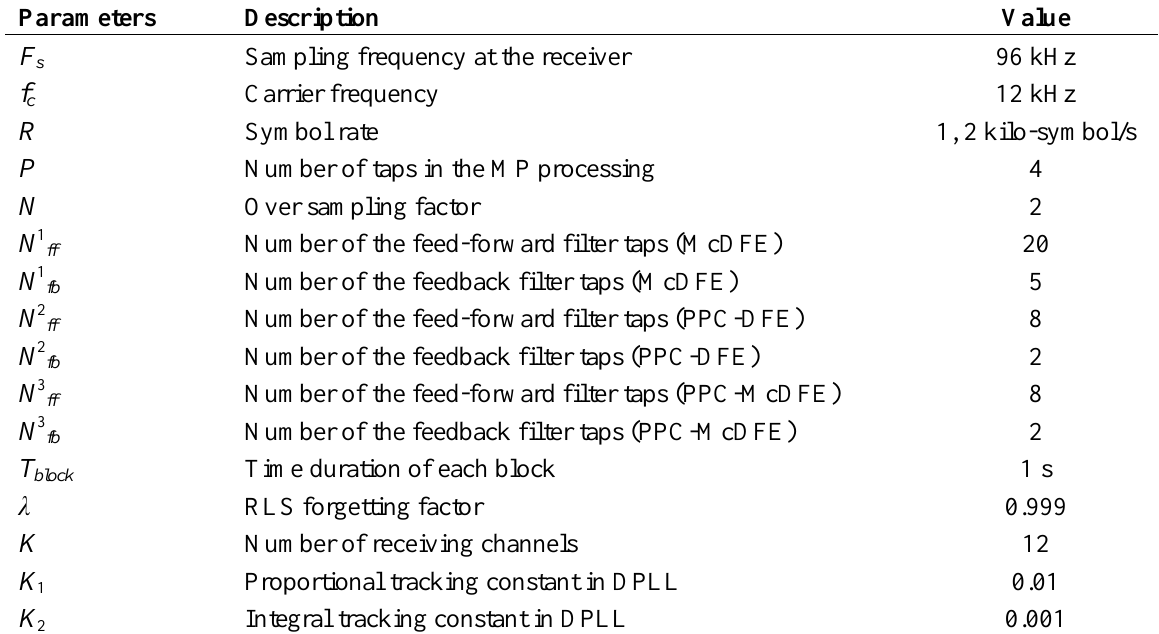
Table 1. Parameters used in the signal processing of the three receiver